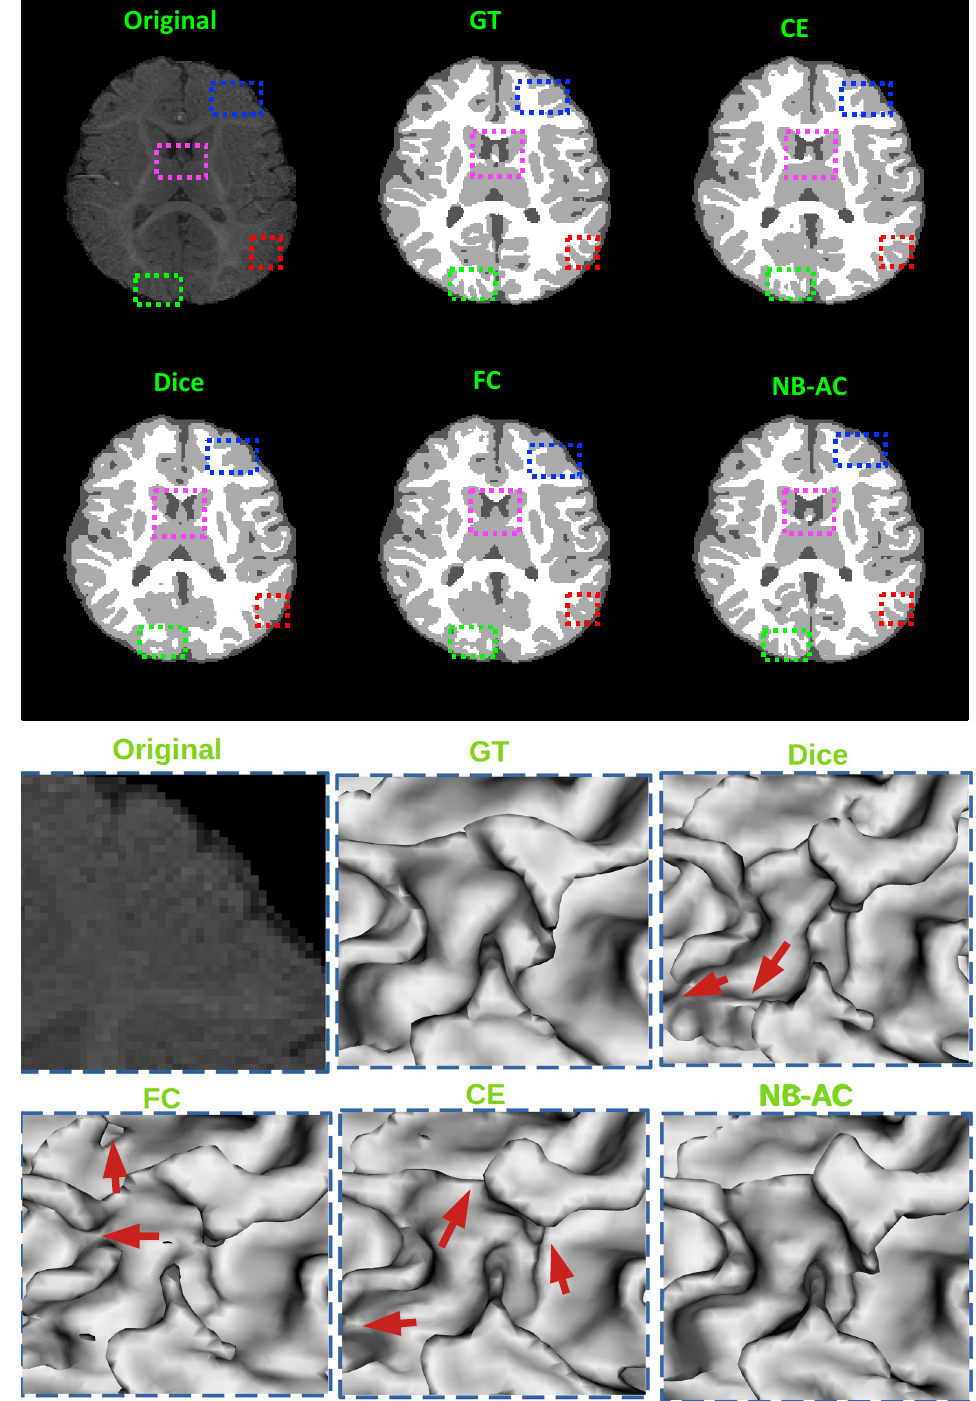
Figure 11. top : Comparison of our proposed NB-AC loss against other loss functions on the iSeg17 dataset with colored boxes highlighting specific differences. bottom : A closer look is also given with the topological errors indicated by red